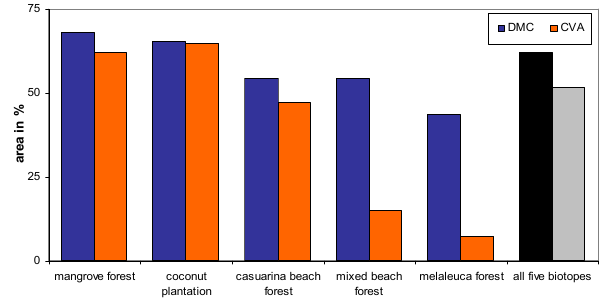
Fig. 13. Estimated damaged area for different forest types based on DMC and CVA.